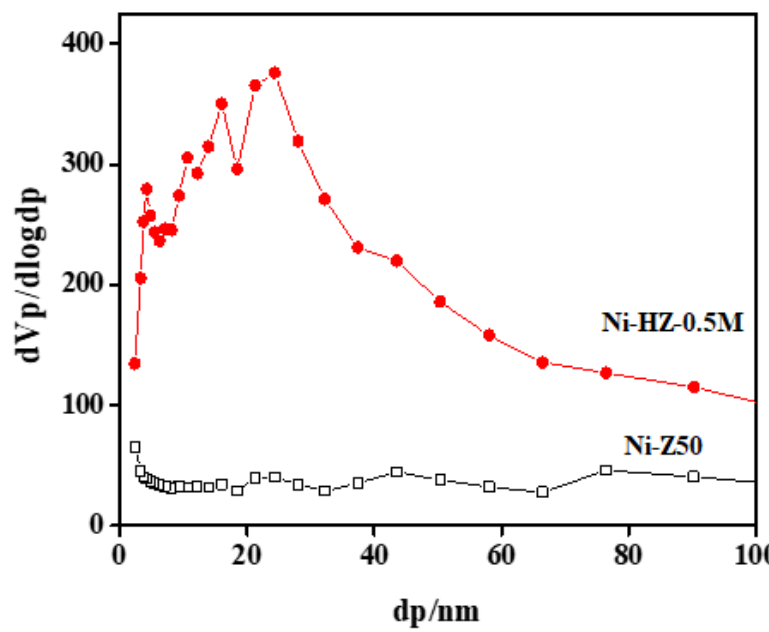
Figure 4. Pore size distribution (BJH) of parent and hierarchical zeolite samples .